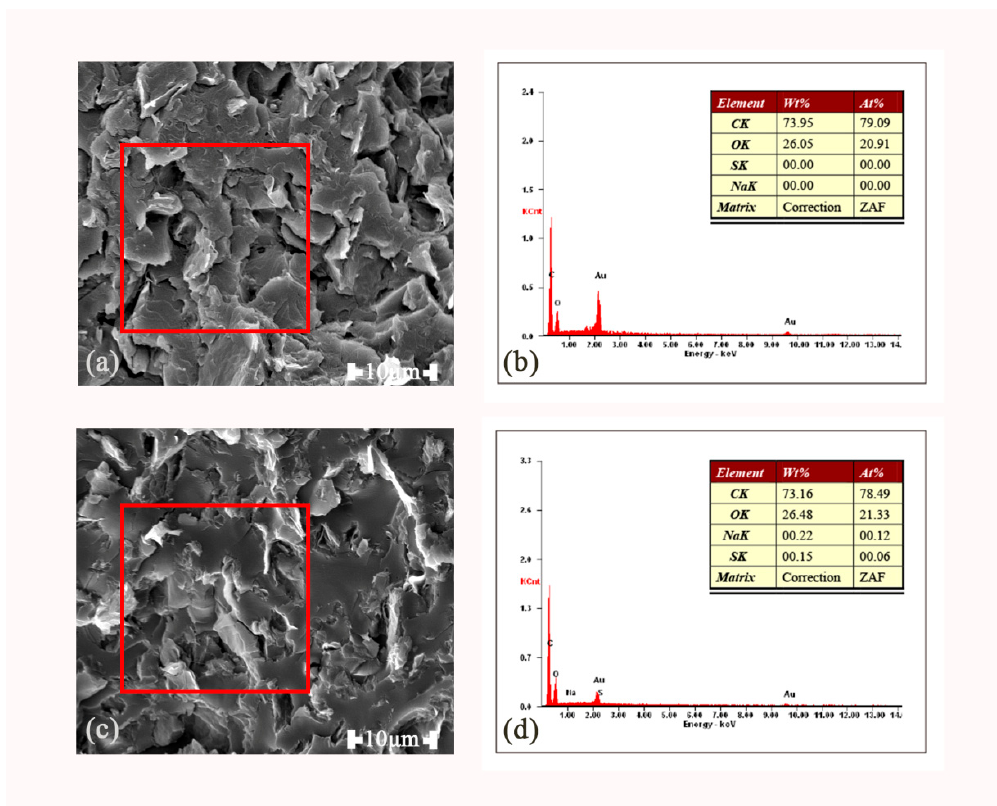
Figure 11. SEM images of rGO ( a ) and rGO–sodium dodecylbenzene sulfonate (SDBS) ( c ) and energy-dispersive spectroscopy (EDX) spectrum of rGO ( b ) and rGO-SDBS ( d ).